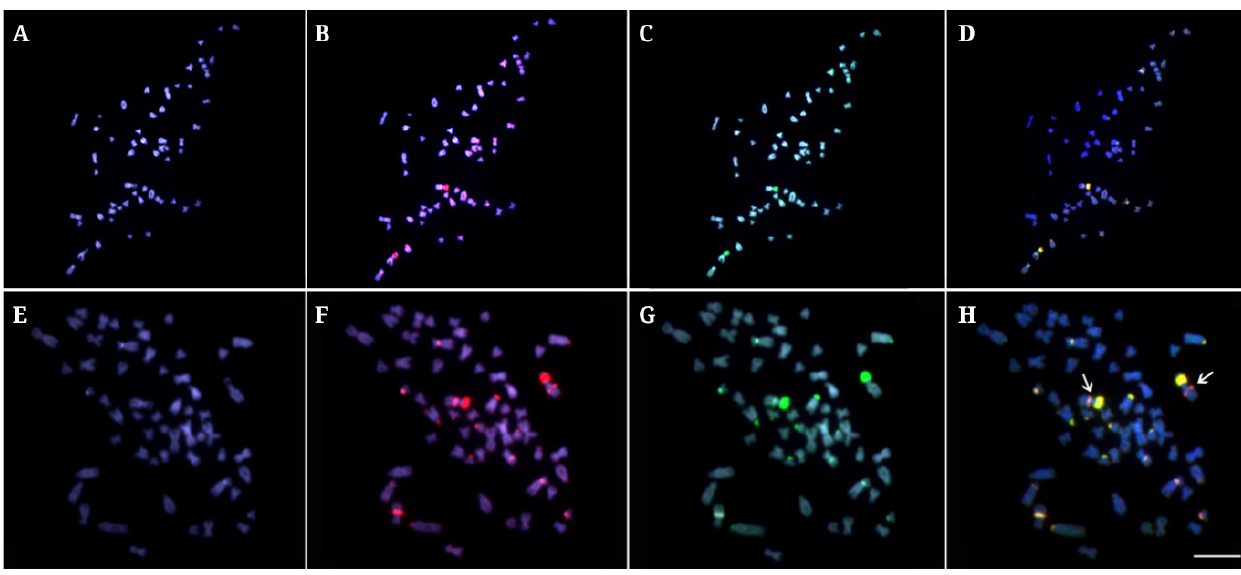
FIGURE 5 | Comparative genomic hybridization (CGH) experiments on metaphase chromosomes of Arapaima individuals from the Javaé (JAV) ( A – D ) and Mamirauá (MAM) populations ( E – H ). First column ( A and E ): DAPI images of chromosomes; Second column ( B and F ): Hybridization pattern using gDNA of A. gigas from MAM population (red): Third column ( C and G ): Hybridization pattern using the gDNA of A. gigas from JAV population (green); Fourth column ( D and H ) overlap of the images. The shared regions are highlighted in yellow. The arrows indicate the higher abundance of some repetitions in individuals from MAM population. Bar=5